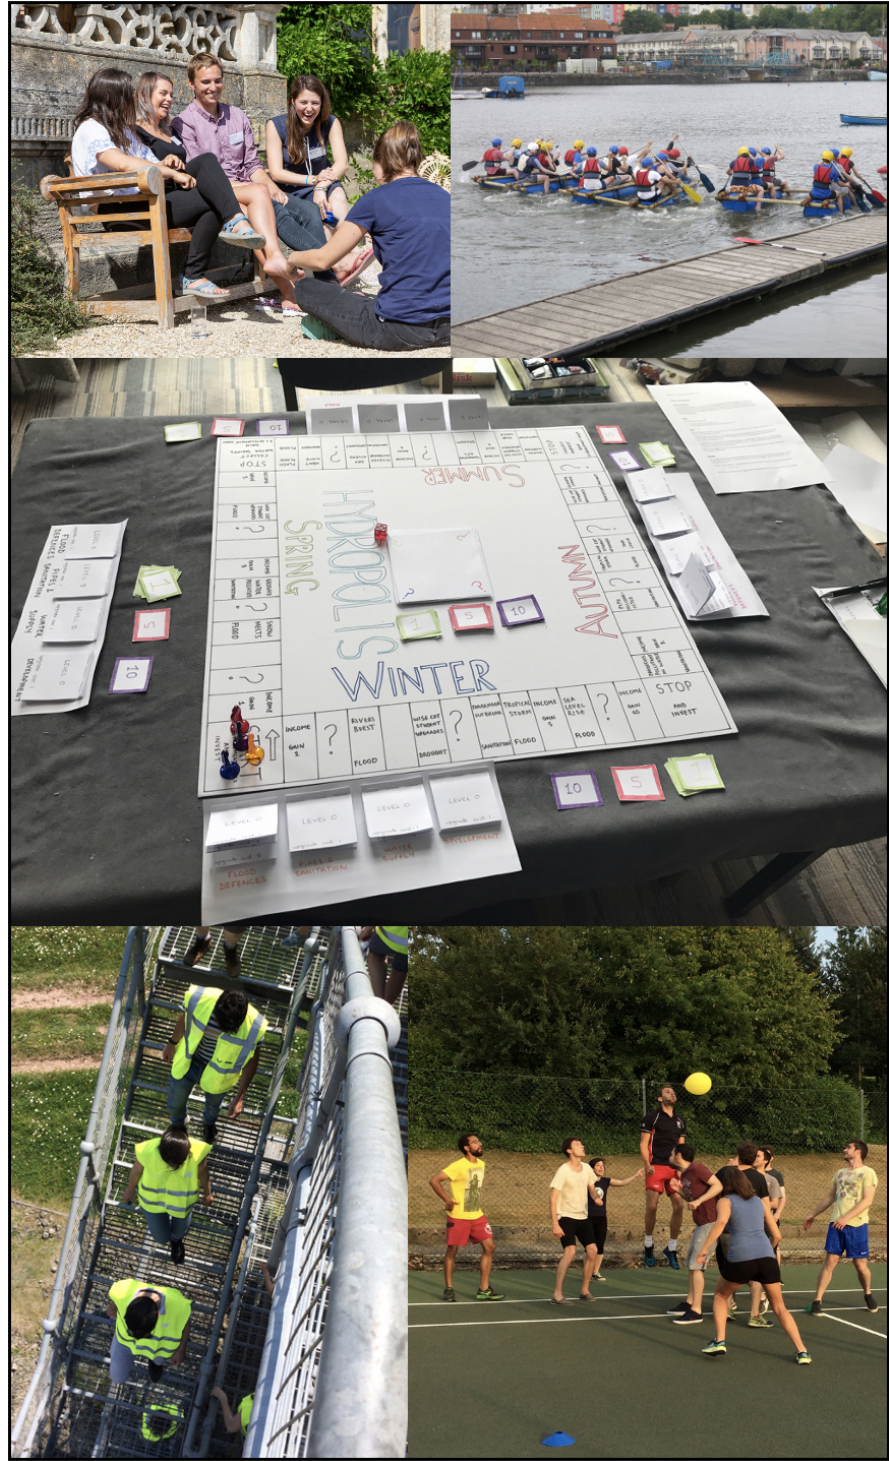
Figure 3. Examples of summer school activities (photo credits: top left © Tim Gander 2018; bottom left and right © Lina Stein 2017).